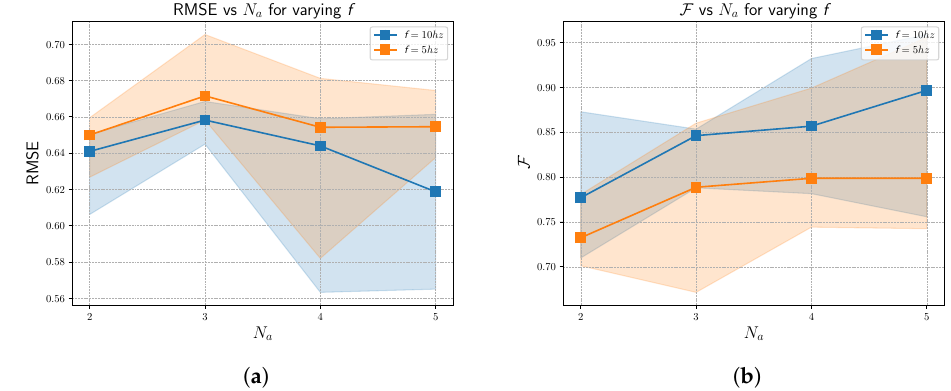
Figure 9. RMSE and fitness plots for varying number of agents N a across different rates. ( a ) RMSE. ( b )